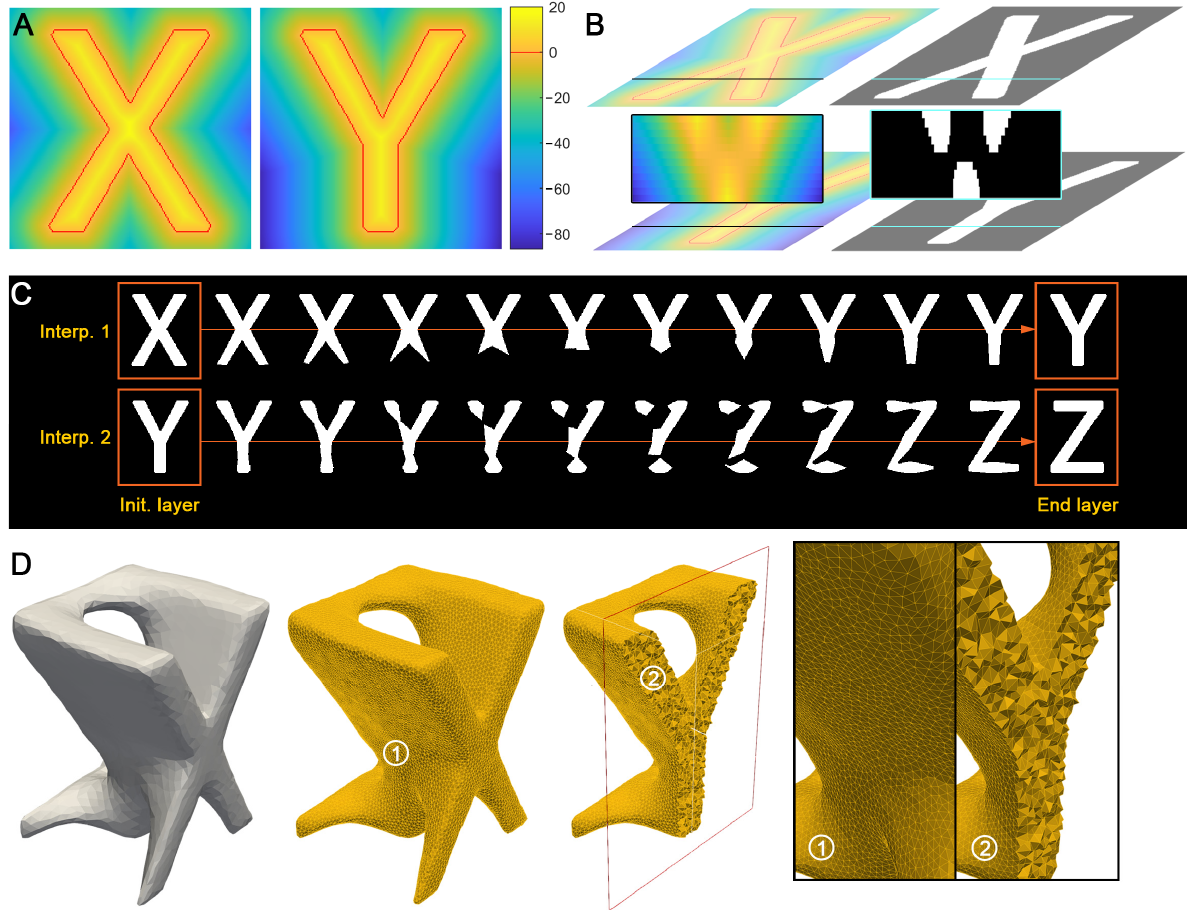
Figure 2. A whole-process demonstration example with an input of three binary layers representing the X, Y and Z letters: ( A ) signed Euclidean distance map of the first two masks (X and Y shapes). Pixels inside the perimeter (red line) present positive distances, whereas exterior pixels are assigned negative values; ( B ) distance maps are interpolated in any number of intermediate layers (left vertical cut) and thresholded to return a binarized volume (1 if distance > 0; 0 otherwise); ( C ) interpolation of 10 intermediate positions (equally distributed) between input and output layers; ( D ) surface mesh reconstruction (.stl format) (left panel), and 3D tetrahedral mesh generated with a transversal cut (middle panel). Insets 1 and 2 show the smoothness and good quality of the elements (right panel).